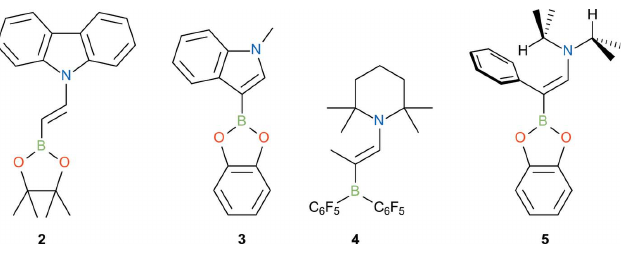
Figure 2 Chemical structure of reference compounds. 9-[( E )-2-(4,4,5,5-Tetra- methyl-1,3,2-dioxaborolan-2-yl)ethenyl]-9 H -carbazole, 2 (Hatayama & Okuno, 2012), 3-(2 H -1,3,2-benzodioxaborol-2-yl)-1-methyl-1 H -indole, 3 (Liu et al. , 2017), 1-{( Z )-2-[bis(pentafluorophenyl)boranyl]prop-1-en-1- yl}-2,2,6,6-tetramethylpiperidine, 4 (Wang et al. , 2018) and N -[( Z )-2-(2 H -